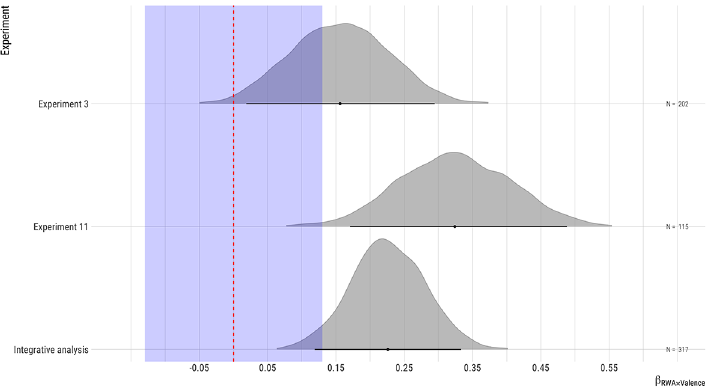
Note. The purple area corresponds to a region of practical equivalence where the values are considered equivalent to 0 (Kruschke, 2018). More information can be found in the Supplementary Materials.